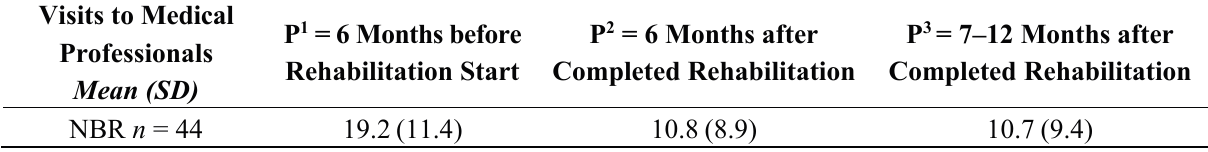
Table 8. Visits to medical professionals for the NBR group displaying mean values and standard deviation (SD) for the measures during P1 1 , P2 2 , and P3 3 .